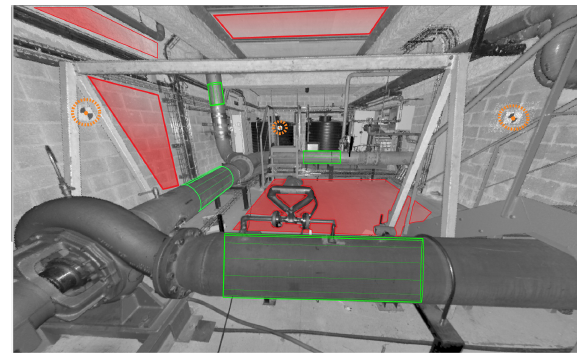
Figure 1: Typical station-based view of an industrial complex scene. Grey level: point cloud coded in intensity. Colour: recon- structed 3D